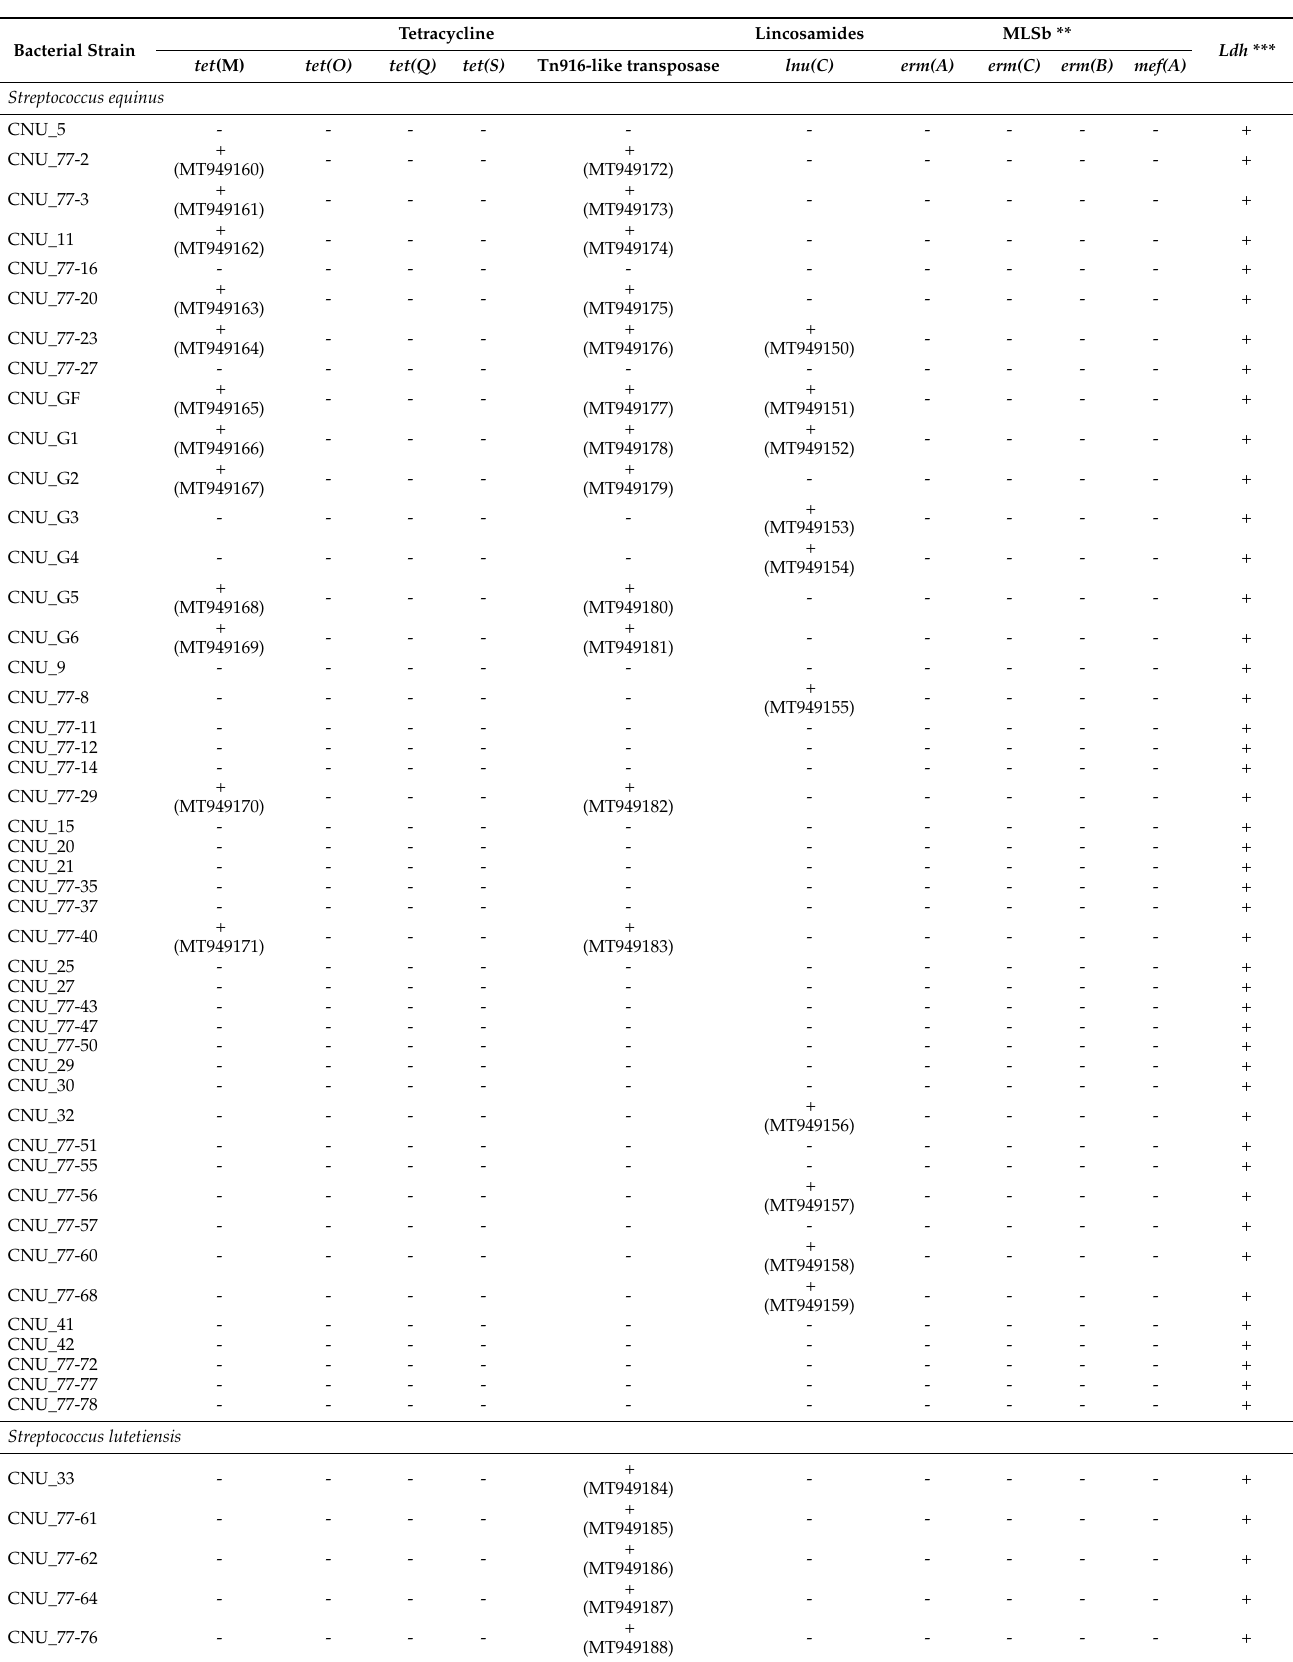
Table 2. List of antimicrobial resistance (AMR)-related genes and ldh genes detected in the SBSEC isolates in this study *. Bacterial